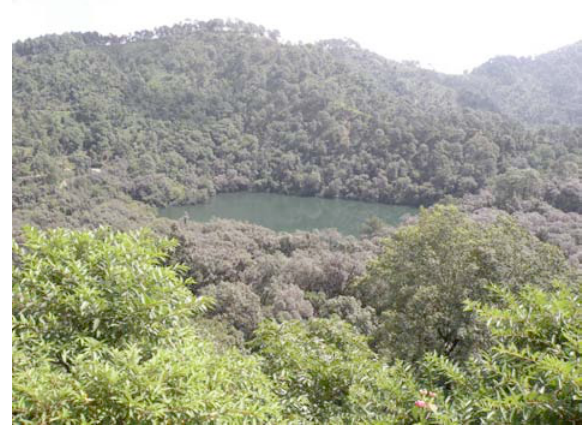
Image 2. Garurtal with the western face of Jones Estate in the